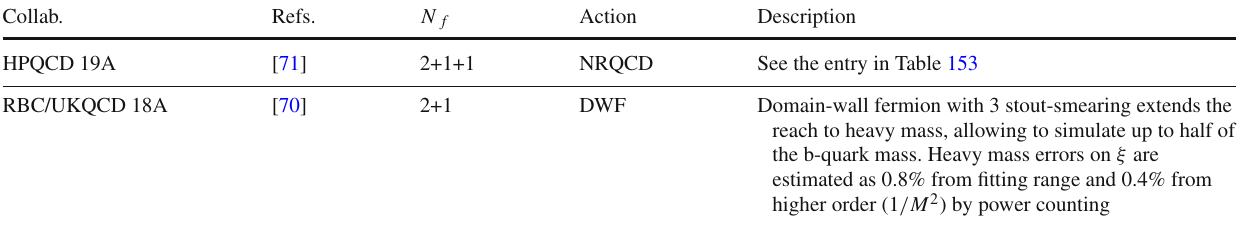
Table 154 Heavy-quark treatment in determinations of the neutral B -meson mixing matrix elements Collab.